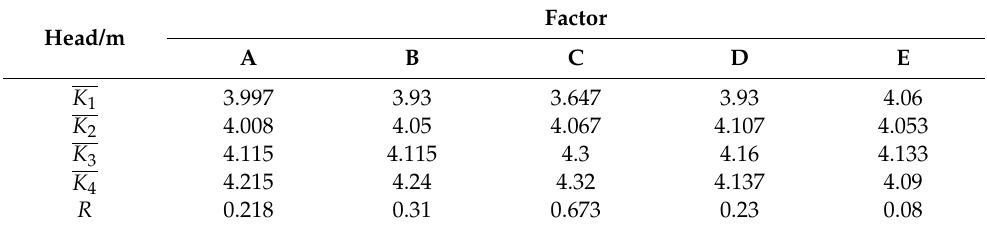
Table 5. Range analysis for pump